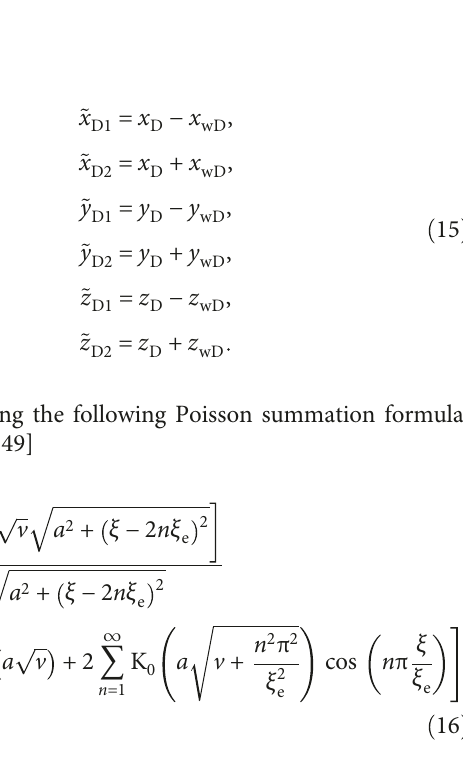
Figure 7: Schematic of a point source in rectangular gas reservoir with closed